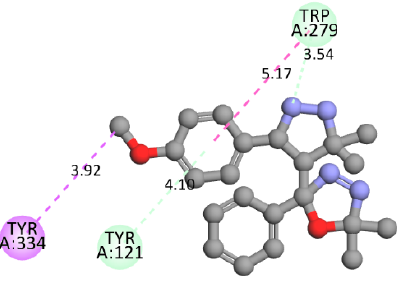
Figure 9. 2D depiction of docking of ligands 1HP14 and 1HP24 in the active site of AChE (PDB ID: 1EVE).